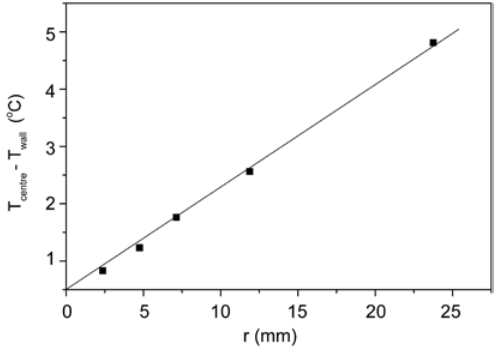
Figure 4: The temperature non-uniformity as a function of reactor radius. Reaction conditions are the same as those in Figure